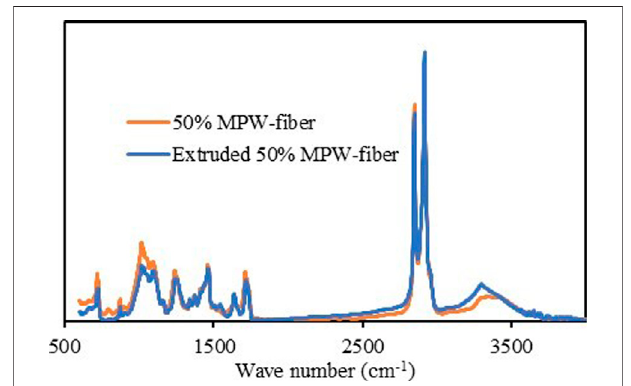
FIGURE 8 | FTIR spectrum of non-extruded and extruded 50/50 MPW- fi ber ratio.